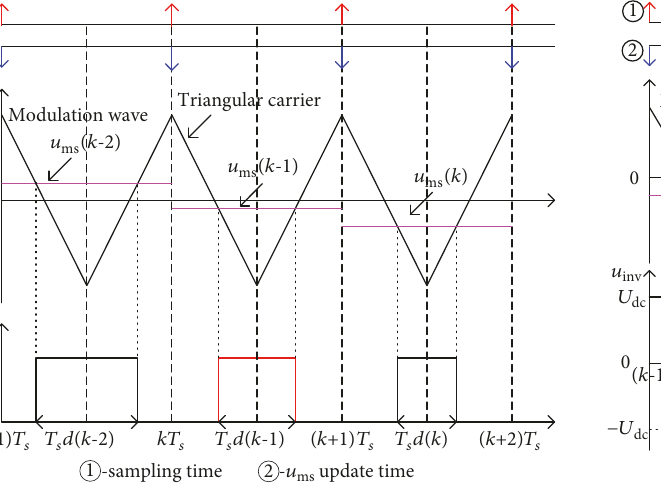
Figure 3: The single update PWM.